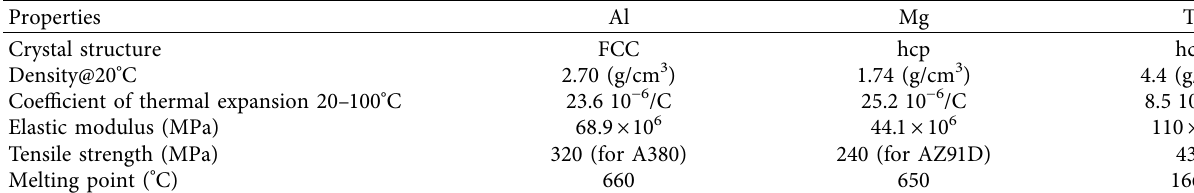
Table 2: Properties of Al, Mg, and Ti [7].